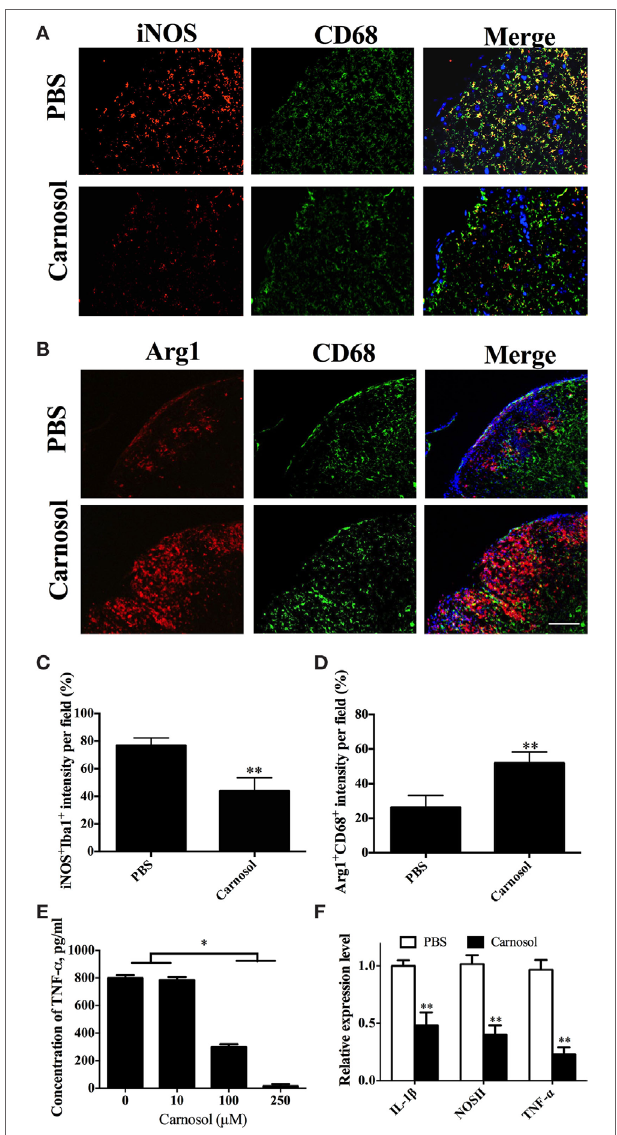
FigUre 7 | Carnosol promoted an M2 phenotype in macrophages/microglia. Spinal cords of mice described in Figure 6 were stained for markers for M1 [iNOS; (a) ] and M2 [Arg-1; (B) ] on microglia/infiltrating macrophages (CD68 + cells). (c,D) Quantitative analysis of the percentages of double positive cells. (e,F) Primary microglia were prepared from newborn B6 mice, stimulated with LPS (100 ng/ml), and treated with carnosol at different concentrations for 2 days and (e) supernatants were harvested for TNF- α production and (F) cells were collected for expression levels of IL-1 β , NOSII, and TNF- α by real-time PCR. Glyceraldehyde 3-phosphate dehydrogenase was used as an internal control. Scale bar = 100 µm. Data are shown as mean values ± SD ( n = 5 each group). ANOVA with Tukey’s multiple comparisons test was used. * p < 0.05 and ** p < 0.01. One representative of three independent experiments is